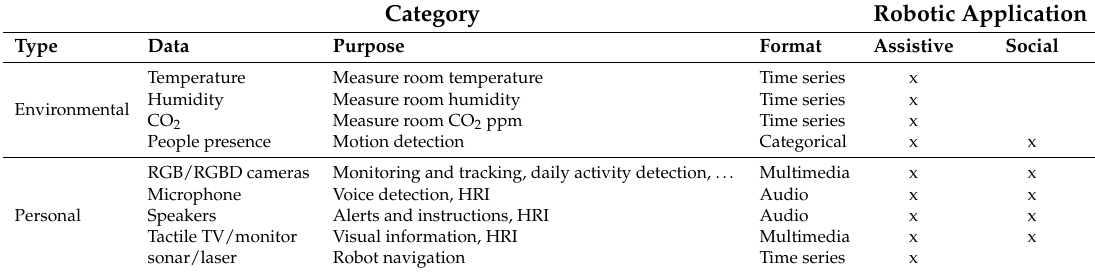
Figure 3. ( a ) Partial view of the physical world W with an RGB camera with wired communication; and ( b ) image capture from the camera labeled as ‘’1” in a). Table 1. Devices list of the CPS-AAL